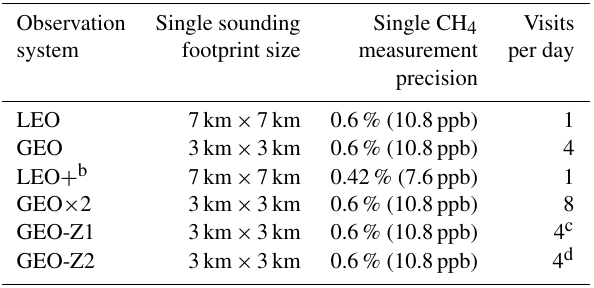
Table 1. Observation system characteristics a . Observation Single sounding Single CH 4 Visits system footprint size measurement per day